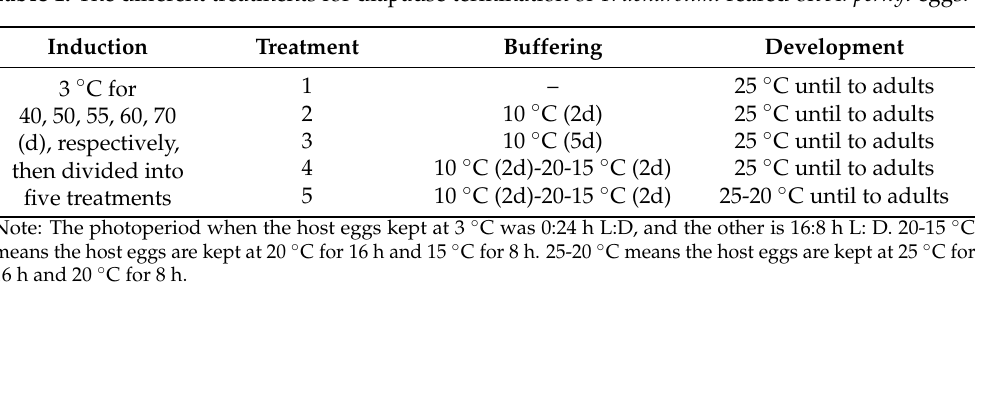
Table 1. The different treatments for diapause termination of T. dendrolimi reared on A. pernyi